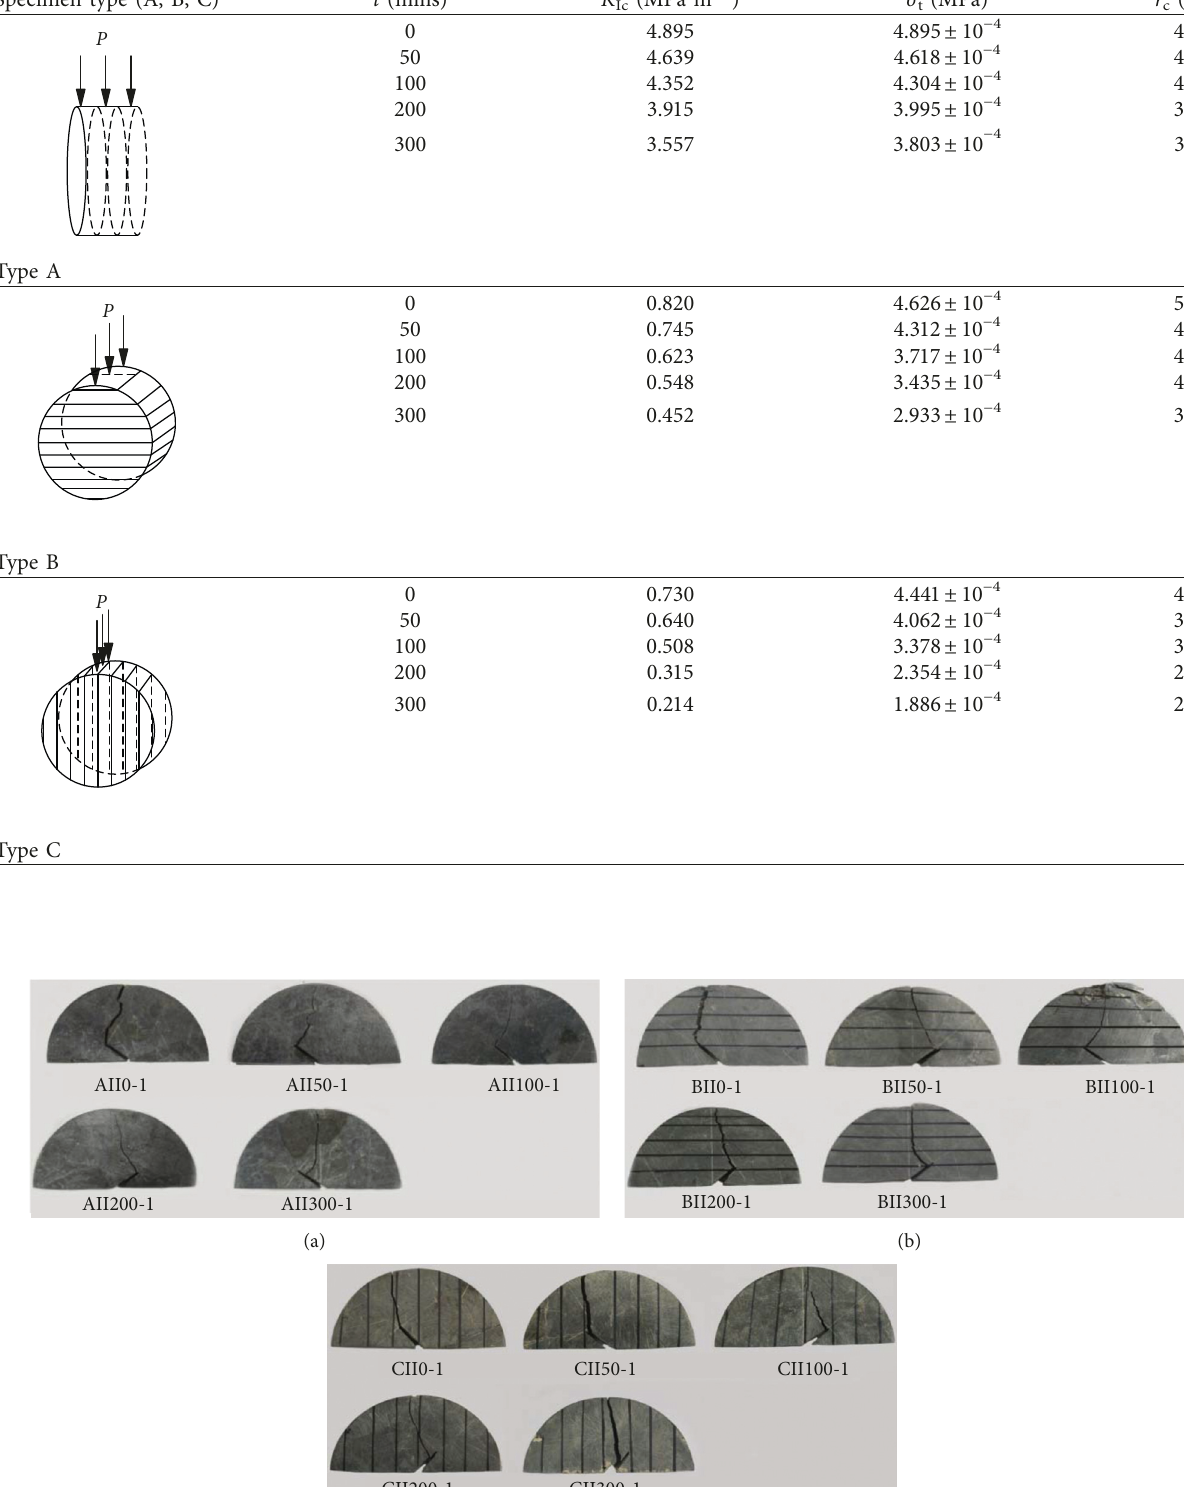
Table 8: The tensile strength and the fracture process zone of the three types of mudstone specimens. Specimen type (A, B, C)